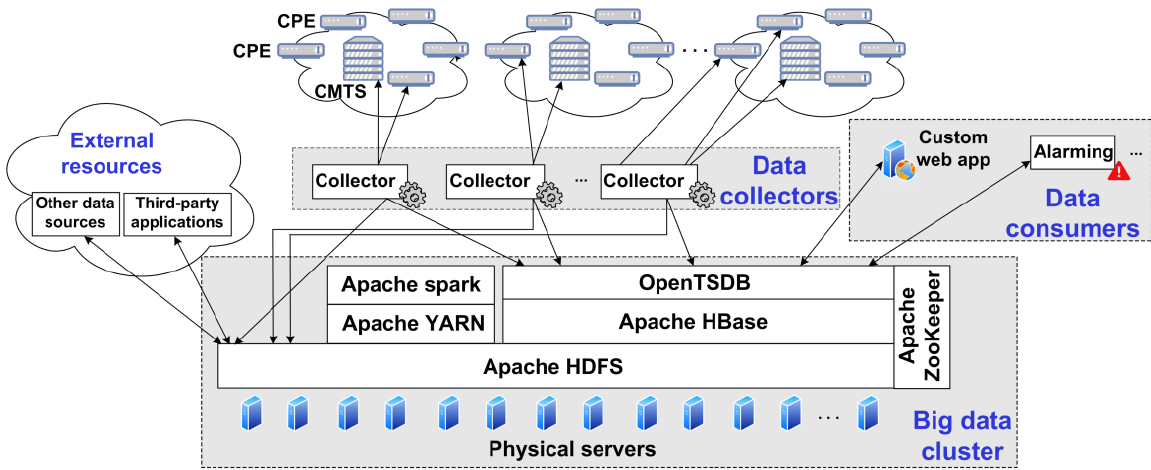
Figure 2. BDPfPM architecture.